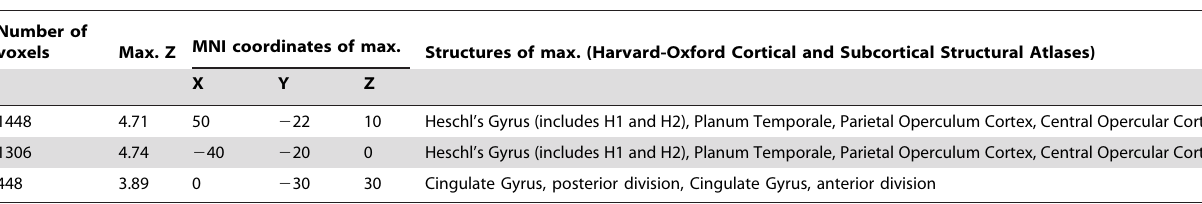
Table 5. Results of the ANOVA analysis of 1 factor at 4 levels of 16 subjects.